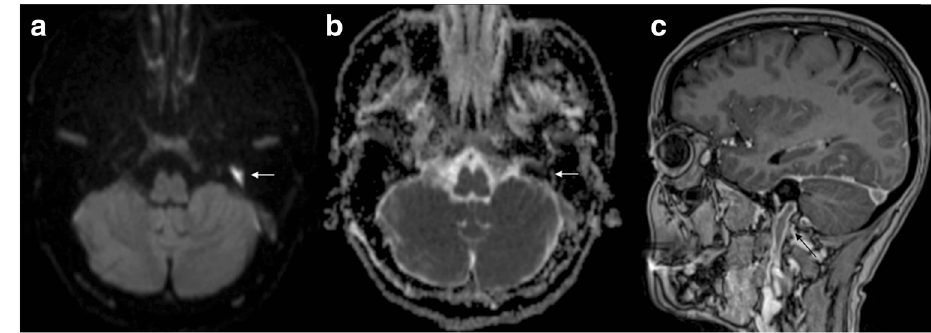
Fig. 4 Venous thrombosis. DWI ( a ), ADC map ( b ) and sagittal reconstruction of T1 3D with gadolinium ( c ) show thrombosis of the left jugular vein (arrows), presenting with restricted diffusion and a fillingdefect inthe vessel after contrast